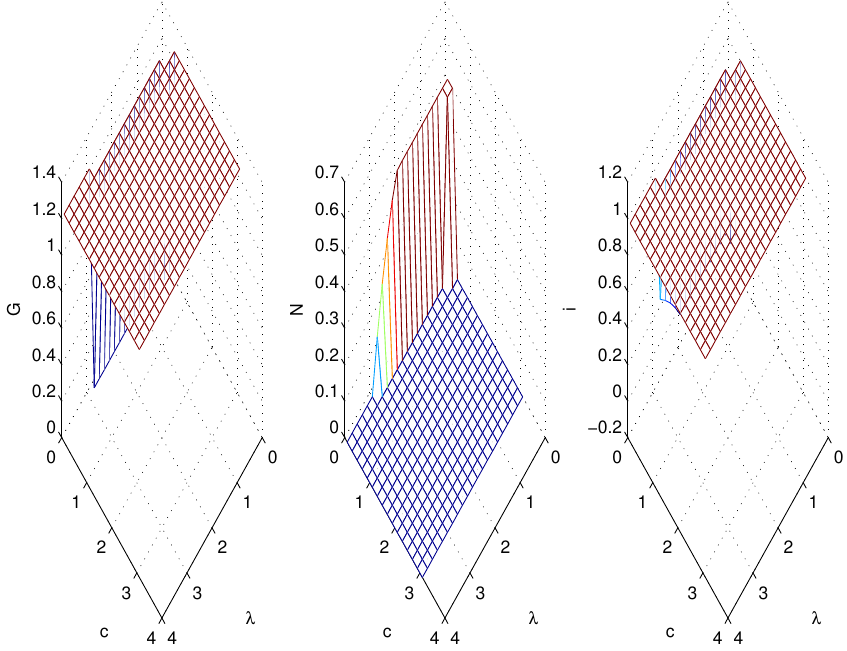
Figure 4. In the c and λ parameter space, similar results hold as for Figure